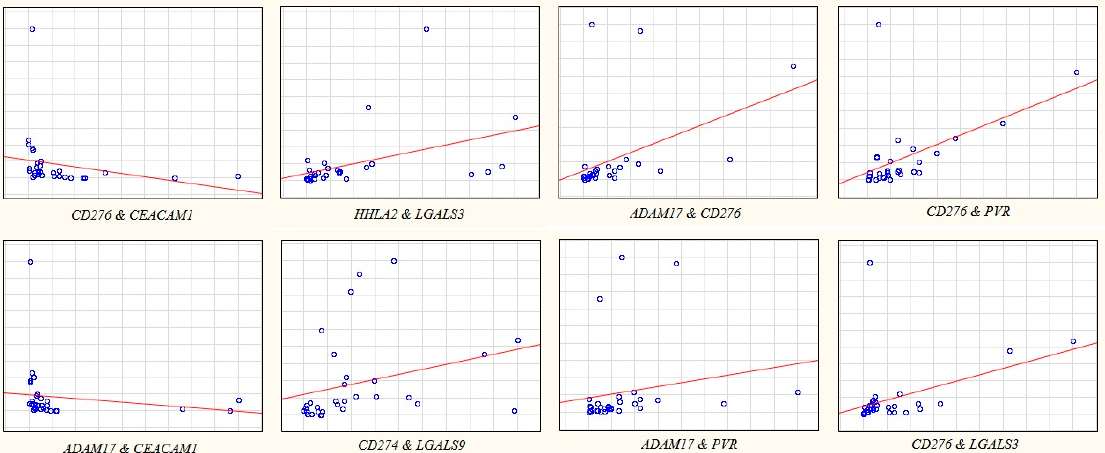
Figure 5. Scatterplot of gene expression at stage IV (metastatic GC).